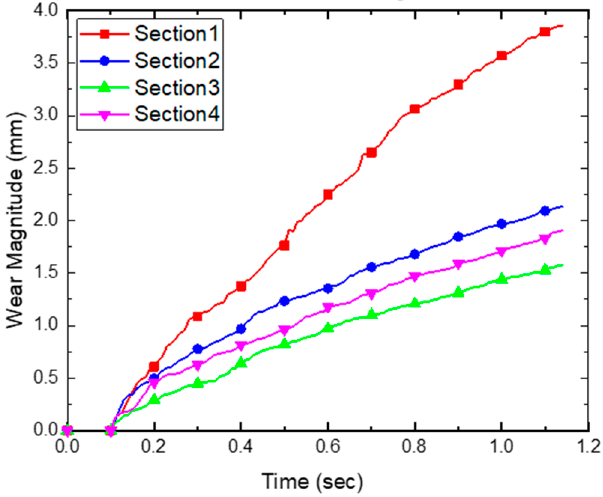
Figure 17. History of wear magnitude (maximum) in each section.